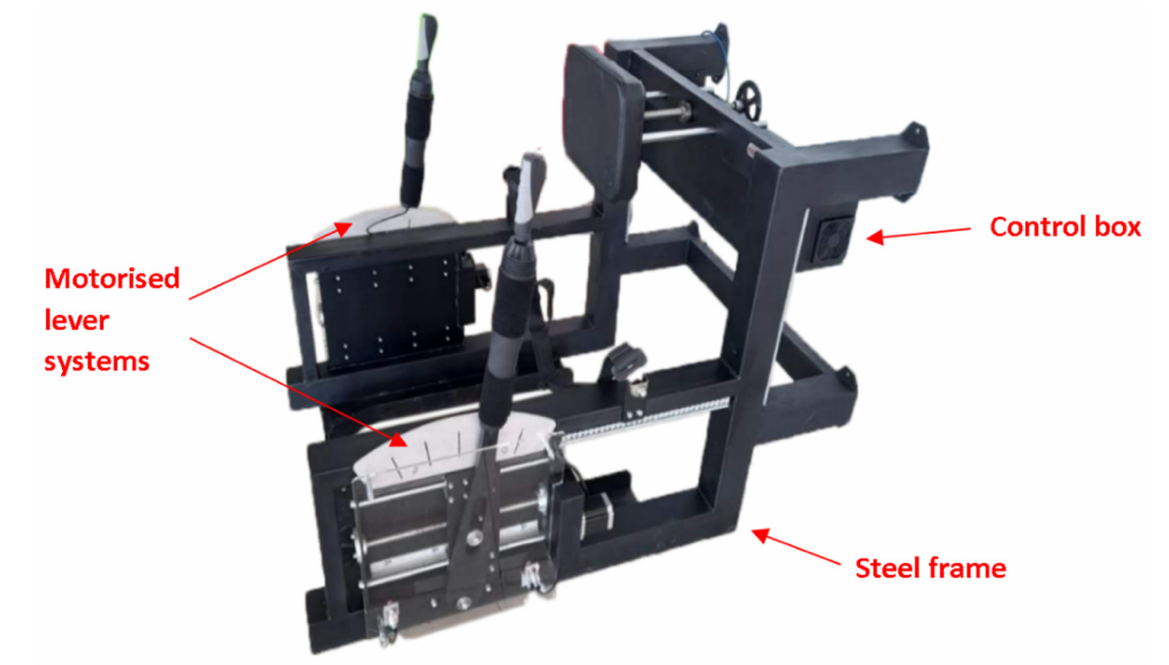
Figure 1. An overview of the device.